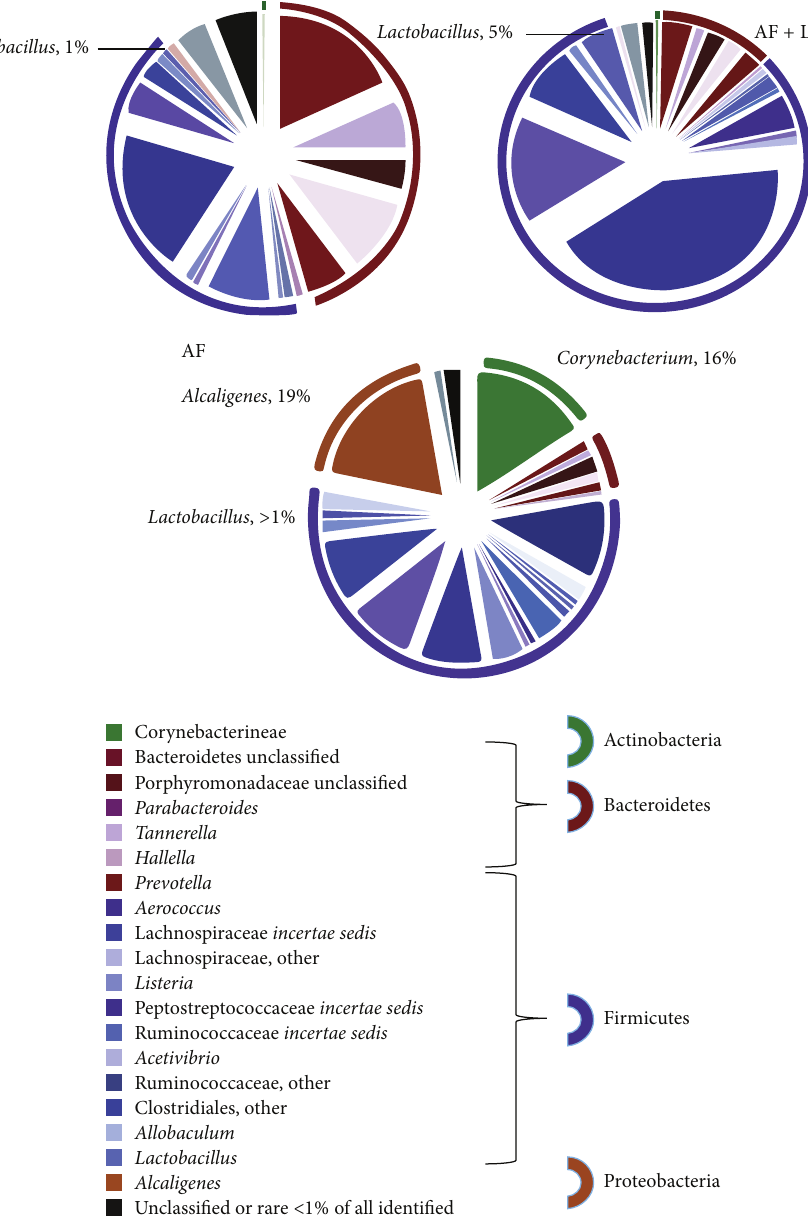
Figure 2: The relative distribution of the bacterial phyla and genera in response to ethanol feeding and LGG supplementation. Mice were fed with Lieber-DeCarli diet containing 5% EtOH or pair-fed with maltose dextrin for 6 weeks. Lactobacillus rhamnosus GG was supplemented at a dose of 10 9 CFU/day for the last 2 weeks with continued alcohol feeding. The fecal samples were analyzed by a metagenomic approach. The microbiome of the PF, AF + LGG, and AF mice is shown in the pie charts and color coordinated by genus and phylum. The different shades of color represent the different genera and the common color spectrum (reds, purples, green, and orange) represents the phyla. The outer ring around the pie charts also depicts the different phyla. The microbiome of AF mice is characterized by greater abundance of Alcaligenes and Corynebacterium and loss of Tannerella . The AF + LGG group shows a much greater abundance of Lactobacillus and nonspecific Ruminococcaceae incertae sedis compared to the other exposure groups (PF: pair-feeding; AF: alcohol feeding; and AF + LGG: alcohol feeding plus Lactobacillus rhamnosus GG, adapted from